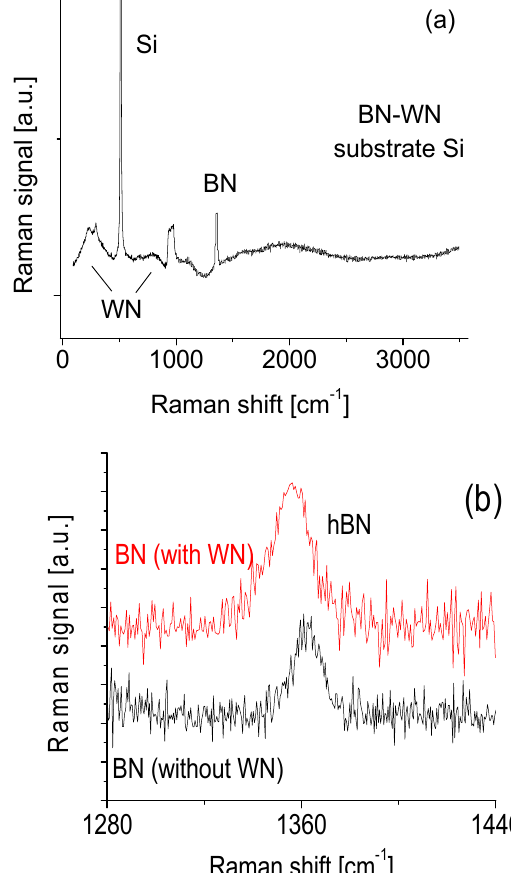
Figure 2. ( a ) Raman scattering spectrum of BN–WN (boron nitride/tungsten nitride) nanocomposite and ( b ) comparison of Raman spectra from BN–WN and BN materials.